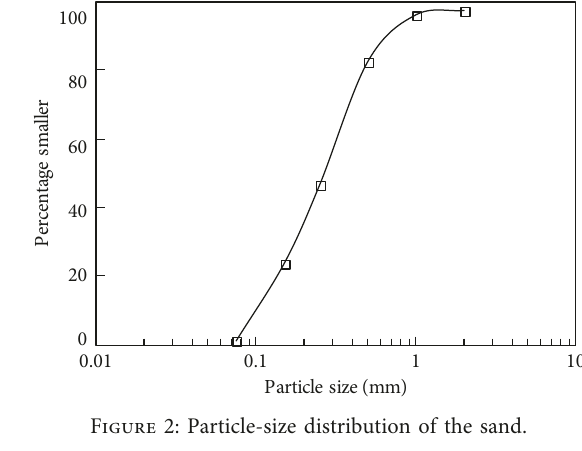
Figure 2: Particle-size distribution of the